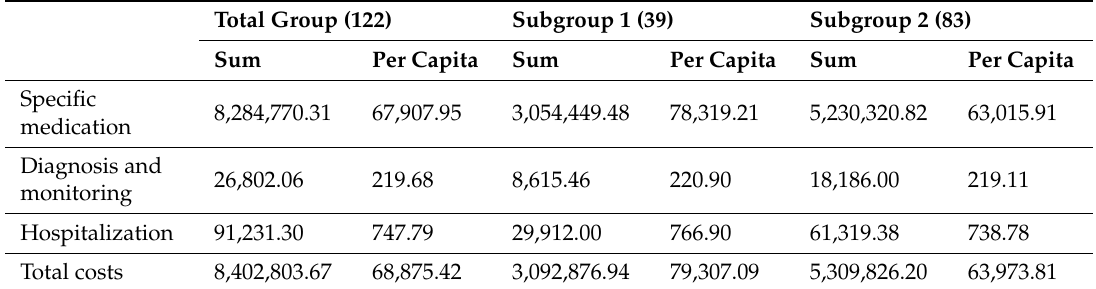
Table 3. Distribution of our real direct costs / patient / year (EUR).